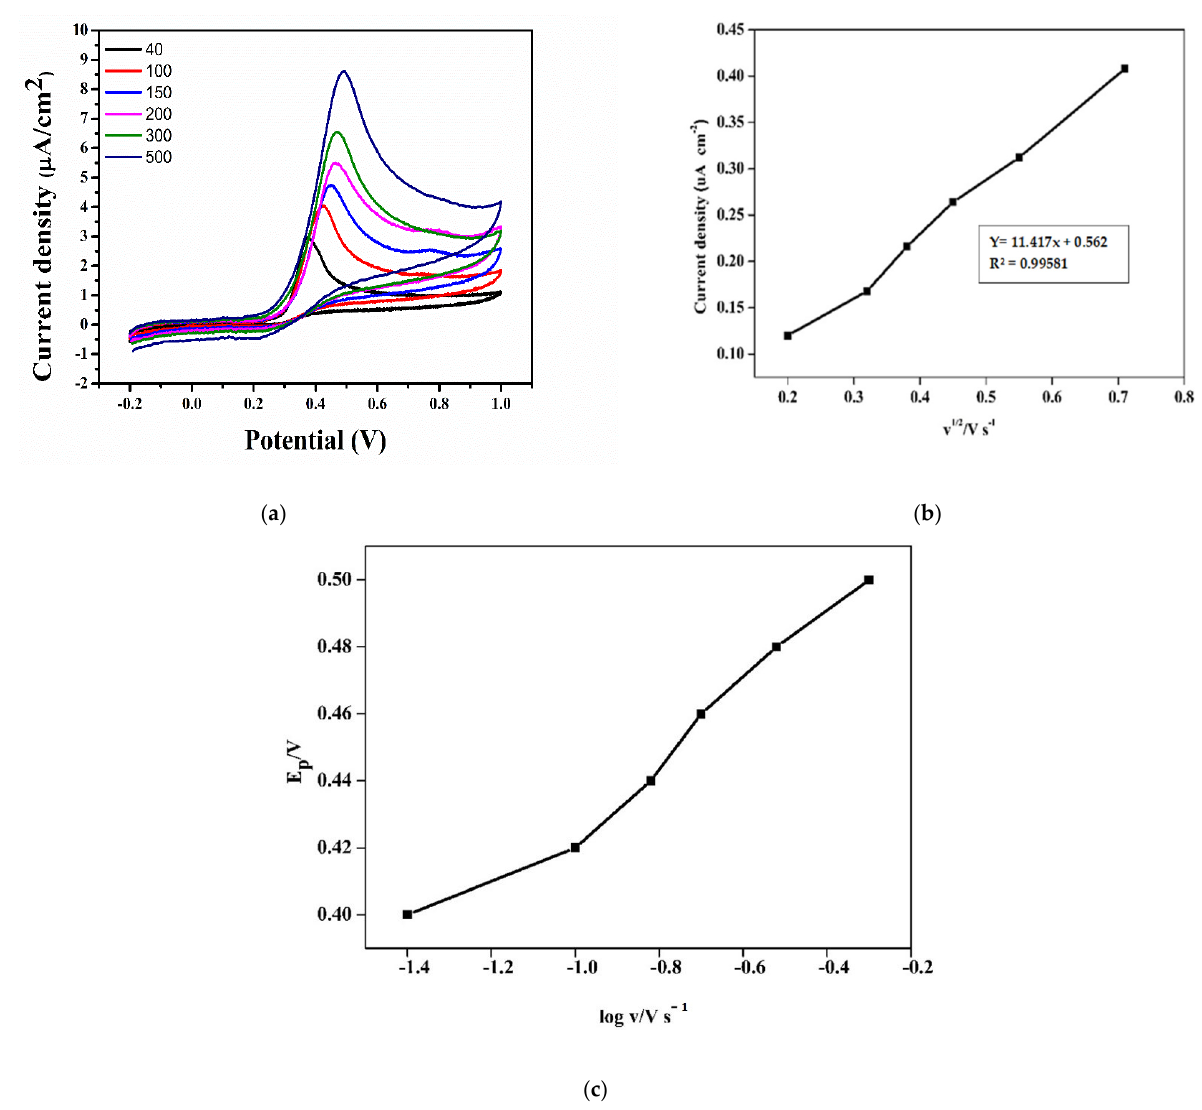
Figure 6. Cyclic voltammograms obtained from ( a ) EPIG in PBS (pH = 7) at different scan rates (curves a to g; 40, 100, 150, 200, 400, 500 mV s − 1 ) in the presence of 50 µ M UA. ( b ) The plot between I p vs. square roots of scan rates ( ν 1/2 ) ( c ) The plot of E p vs. log ( ν ).